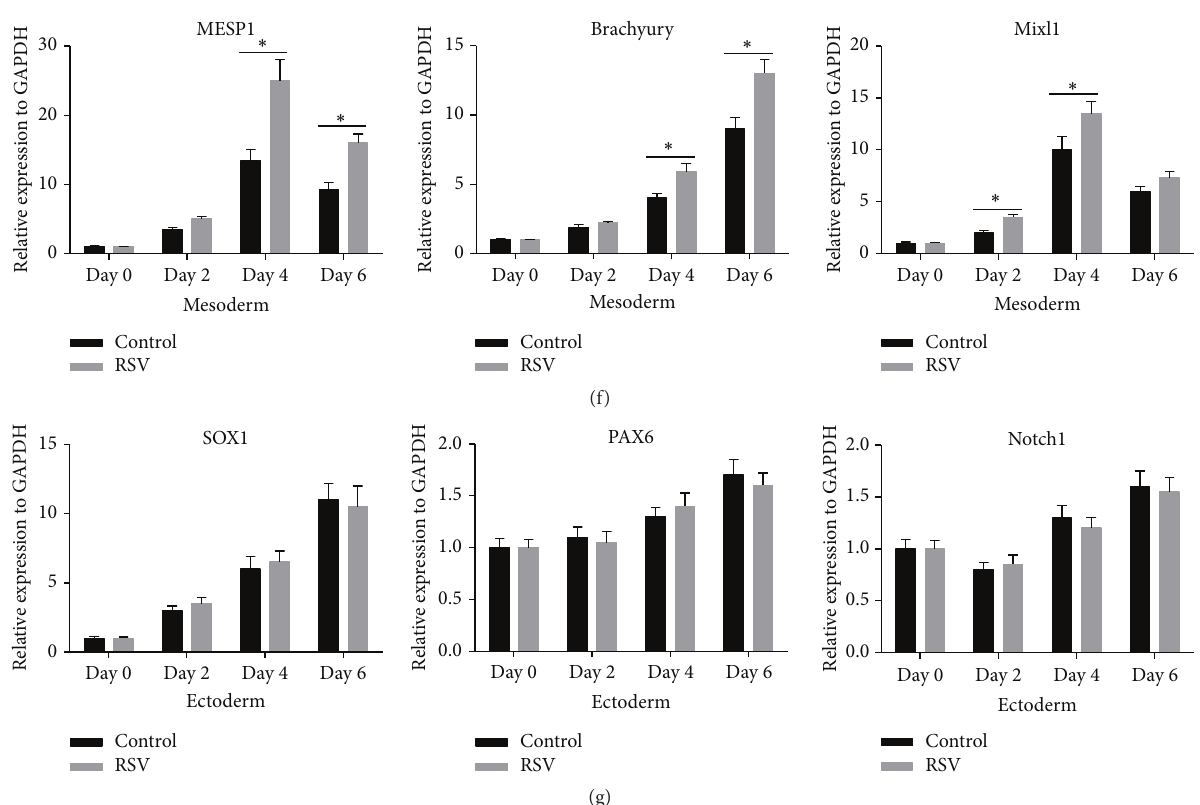
Figure 1: RSV has no effect on the self-renewal of human iPSCs but can promote mesoderm differentiation. (a) Representative images of the human iPSCs morphology 5 days after different concentrations of resveratrol treatment (10x). (b) Quantitative RT-PCR (qRT-PCR) analysis of pluripotent markers Oct4, Sox2, NANOG, and KLF4 in human iPSCs 5 days after RSV administration. (c) Cell proliferation assay was performed using CCK-8. (d–g) Under embryoid body (EB) condition, dynamic gene expressing profile of pluripotency (d), endoderm (e), mesoderm (f), and ectoderm markers (g) were detected by qRT-PCR analysis. Data represent the mean ± s.d. of three biological replicates. ∗ 𝑃 < 0.05 .